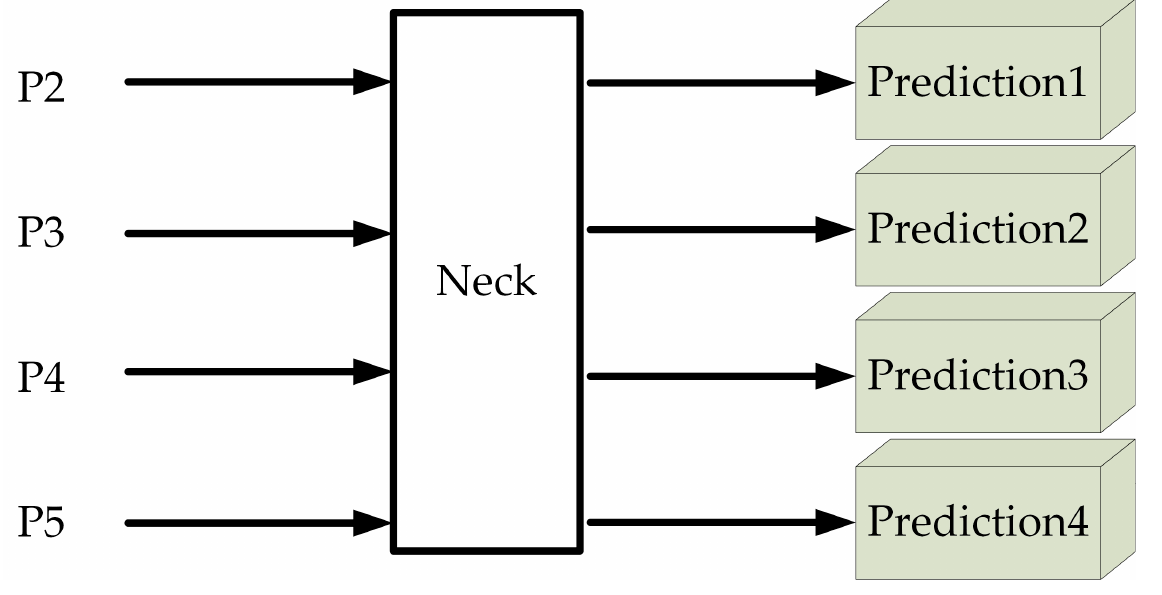
Figure 12. Prediction network optimization.